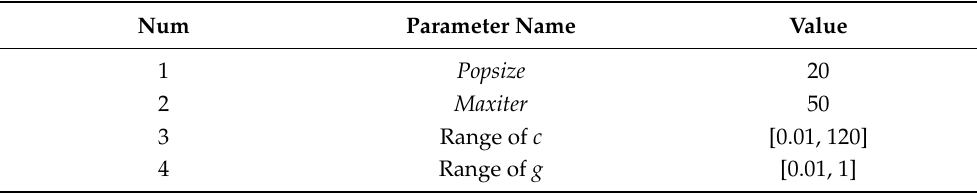
Table 3. Initial parameters of IPSO.